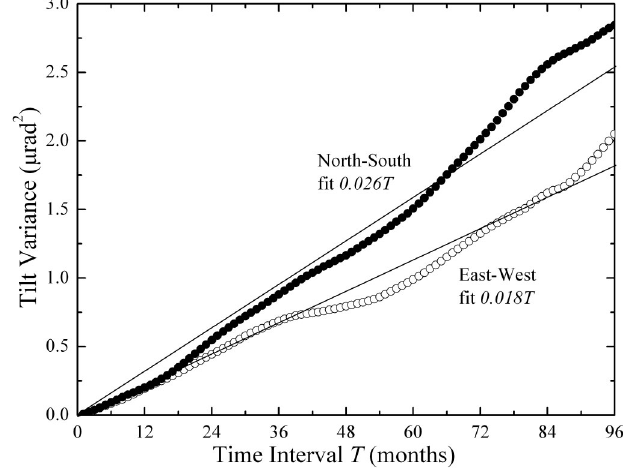
FIG. 28. Variance of the tilt elevation vs time interval (from Ref. [17]).